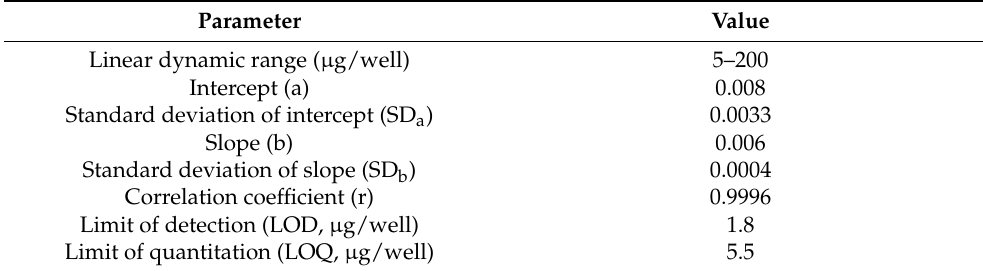
Figure 7. The calibration curve for the determination of LOR by MW-SPA via formation of CTC with DDQ. Linear regression equation and its correlation coefficient ( r ) is given on calibration line. Table 4. Calibration parameters for LOR quantitation by MW-SPA via formation of colored CTC with DDQ.